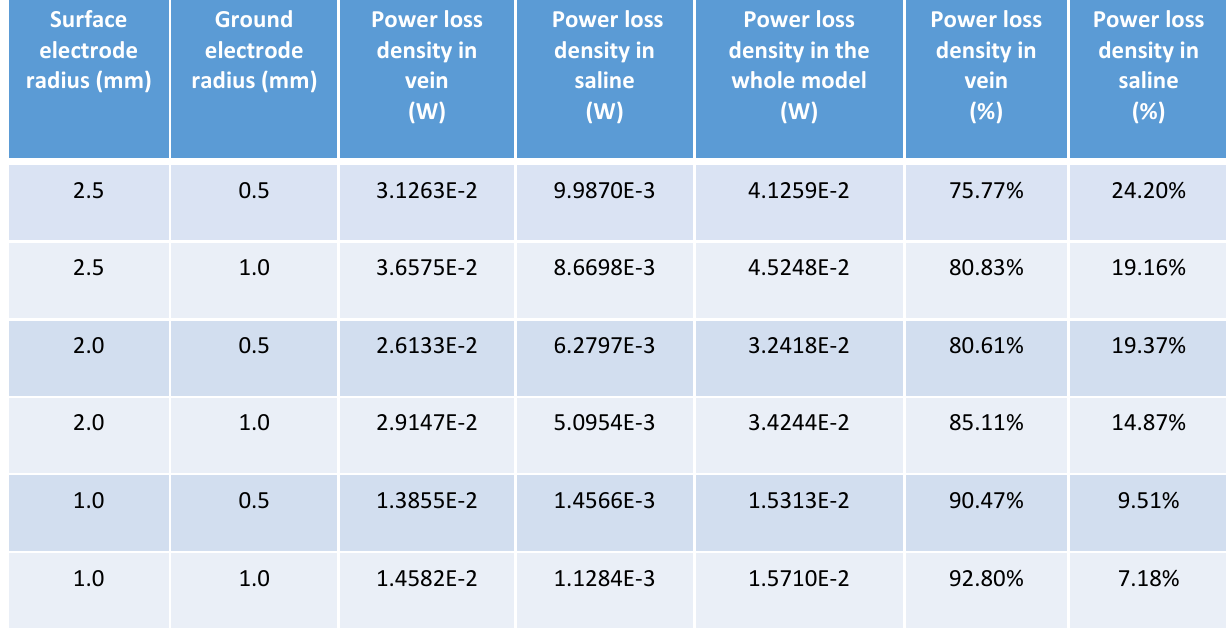
Table.3: Volumetric power loss density measurements at 1 MHz with all 28 surface electrodes excited simultaneously as terminals (7 electrodes in 4 rows)